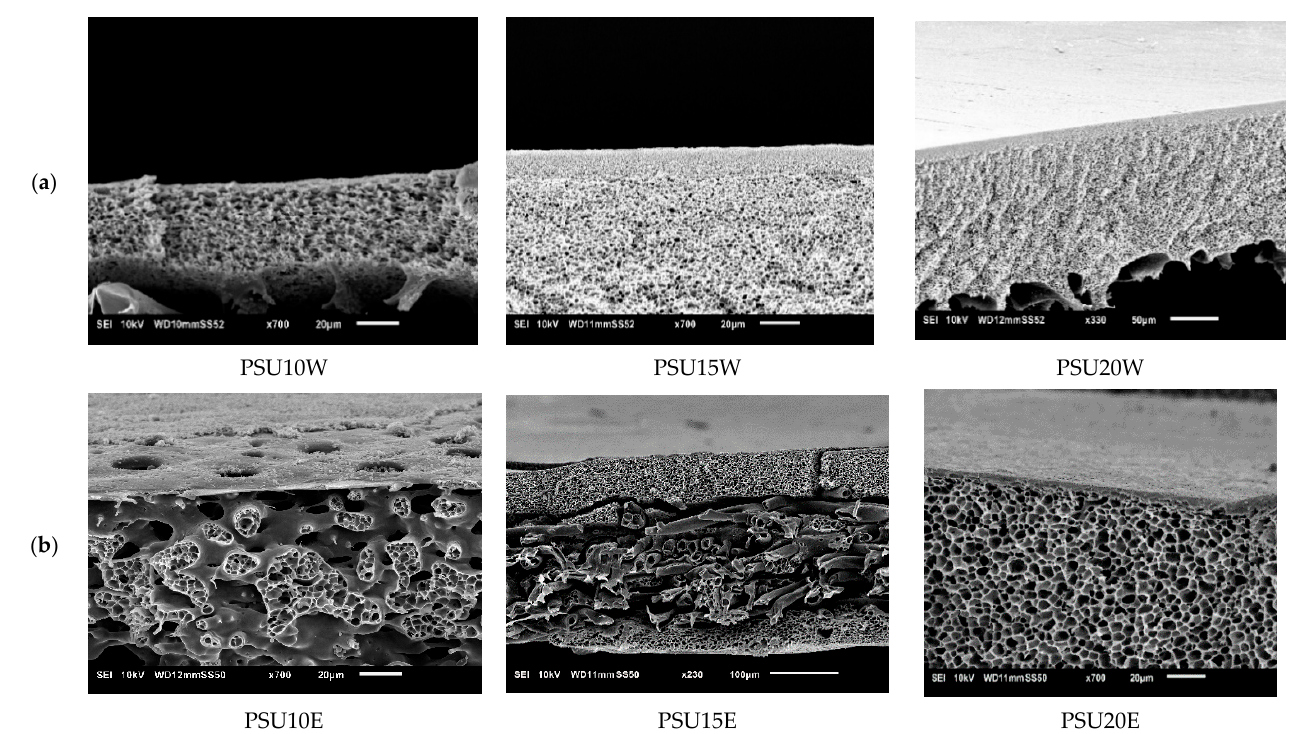
Figure 12. Influence of polysulphone (PSU) concentration on membrane performance in term of RB rejection and permeance Striped lines represent membranes prepared using ethanol as non- solvent and full lines those with water as non-solvent.